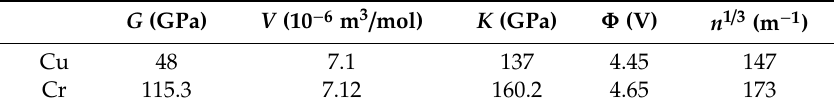
Table 1. Parameters to calculate enthalpy, entropy and Gibbs free energy for the Cu-Cr